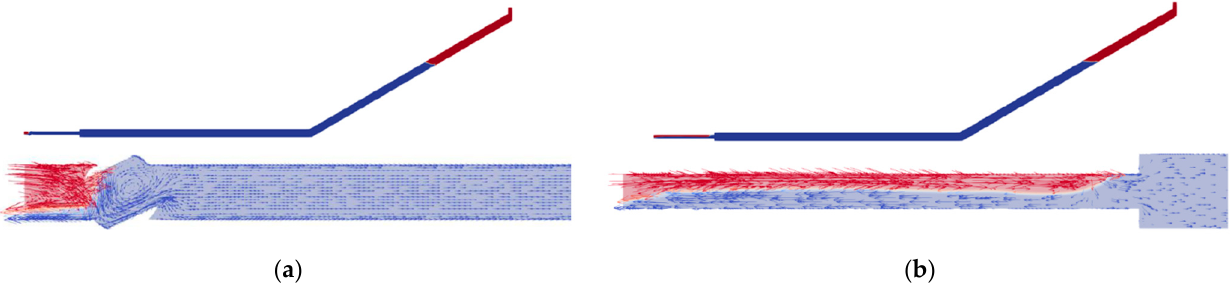
Figure 6. Comparison of water velocity patterns between the experimental model and the 2D CFD OpenFOAM symmetry model for cases B: ( a ) run B4; ( b ) run B5; ( c ) run B6.